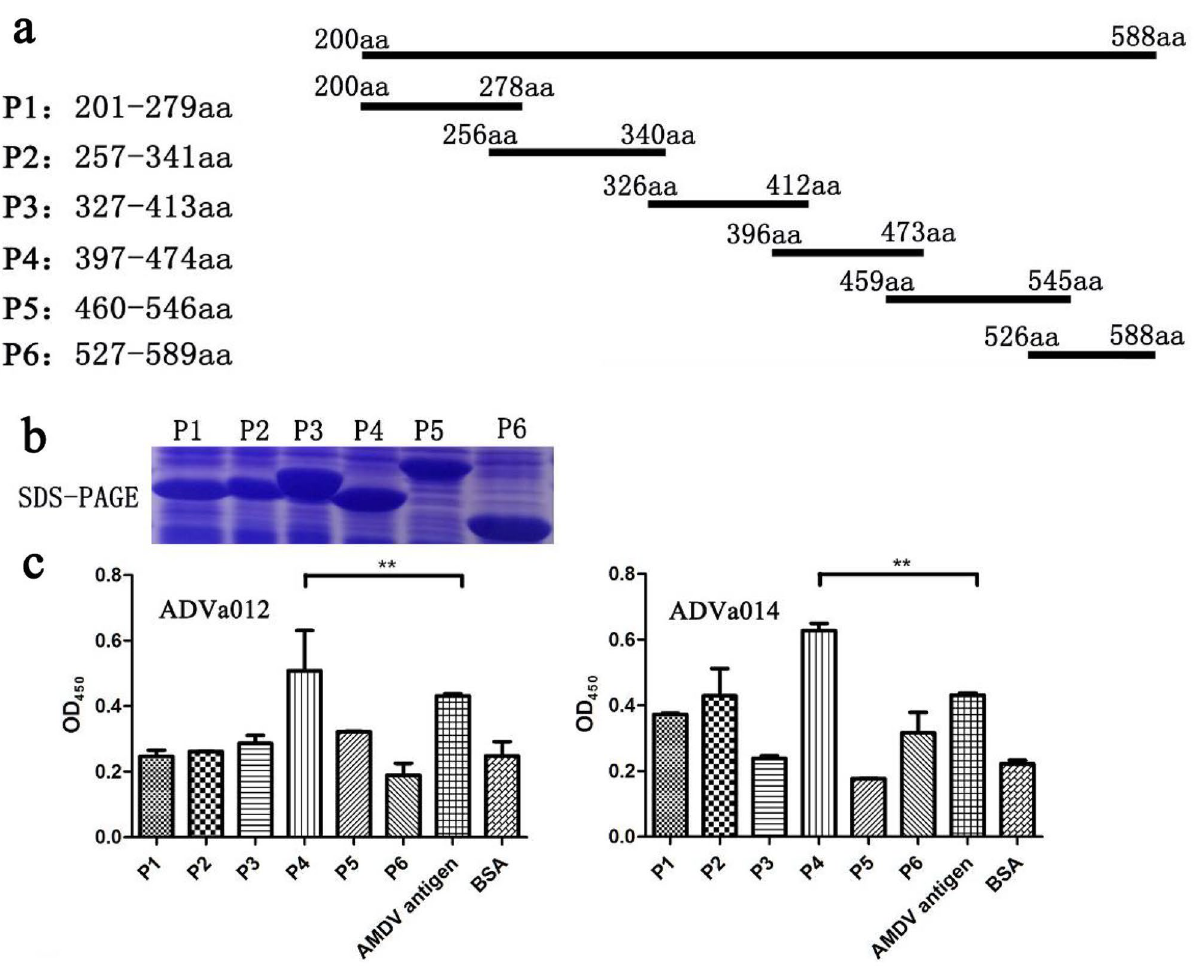
Figure 5. Domains on VP2 protein recognized by aptamers. ( a ) Six overlapping His-fused fragments spanning the VP2 protein were designed; ( b ) The six recombinant truncated His-fused proteins (P1 to P6) were expressed in a prokaryotic expression system; ( c ) Binding affinities of ADVa012 and ADVa014 for different domains of the VP2 protein were measured by ELONA. The six recombinant truncated His-fused proteins (P1 to P6) were coated onto the plates and biotin-labeled aptamers were added. The AMDV antigen and BSA were used as positive and negative controls. The P4 fragment is involved in binding to ADVa012 compared with AMDV antigen (P = 0.0025, P < 0.01), and is also involved in binding to ADVa014 in comparison with the AMDV antigen (P = 0.0041, P < 0.01). Results are the averages of three independent experiments performed in triplicate.*P < 0.05; **P <